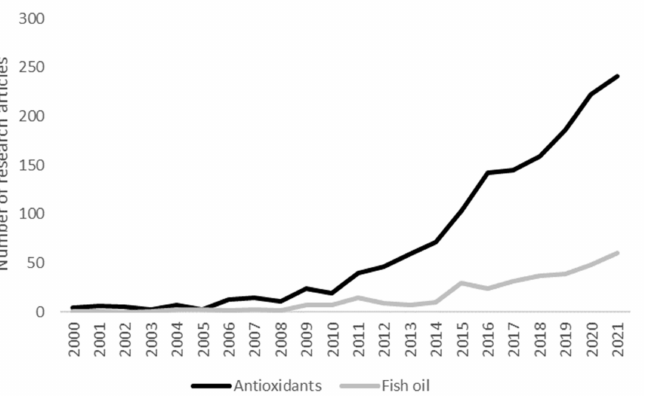
Figure 1. Chronological evolution in the number of research articles about microencapsulation of fish oil and natural antioxidants in the last two decades (data obtained from Web of Science, November